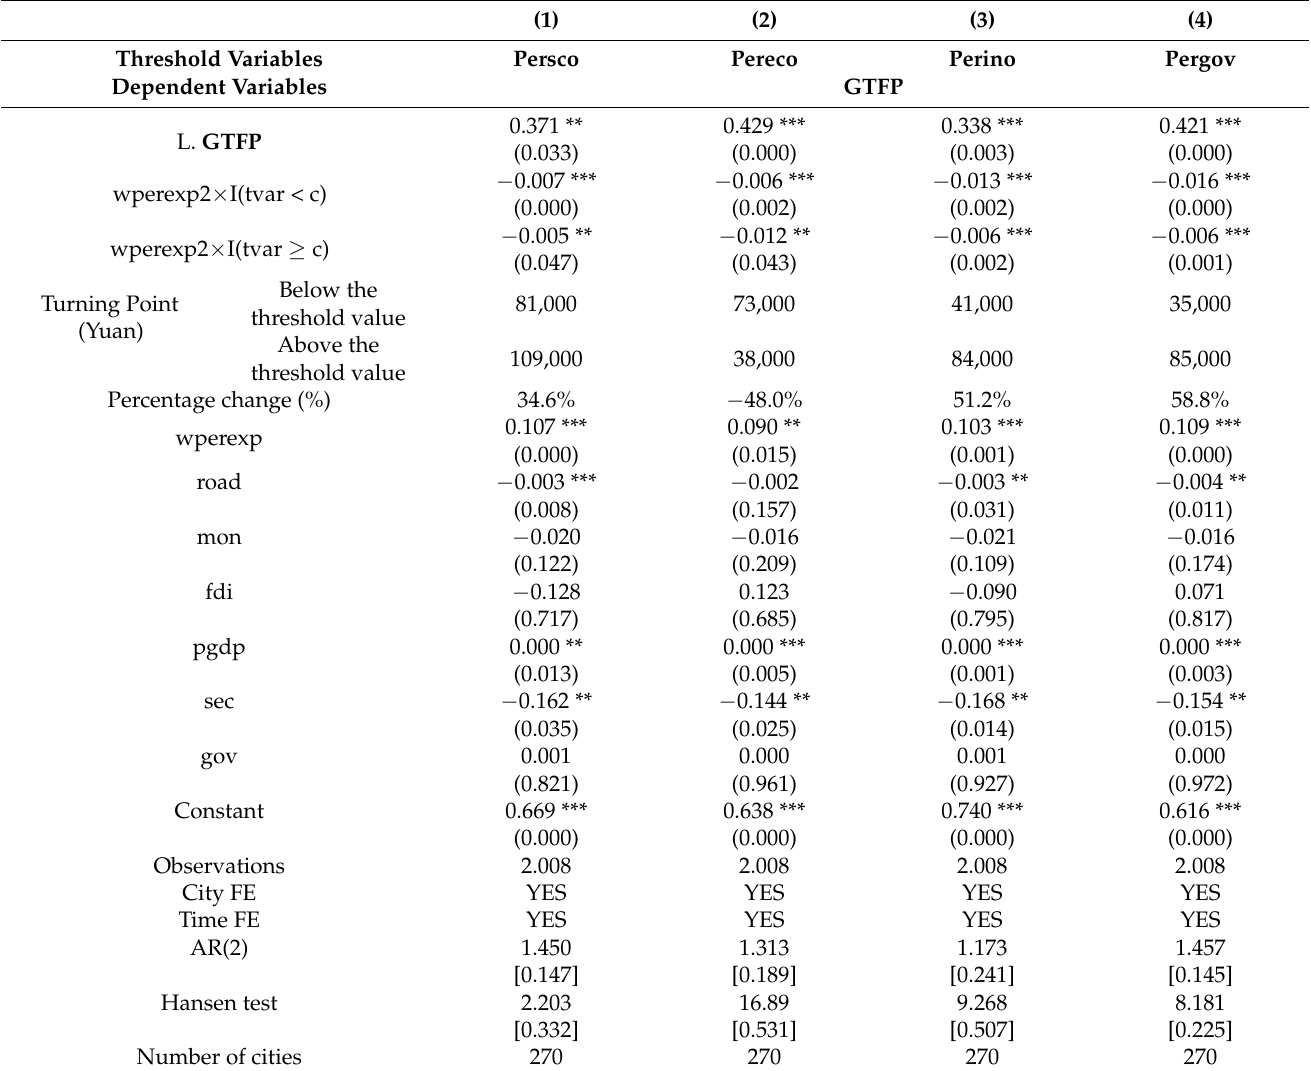
Table 10. Estimation results of the dynamic threshold panel